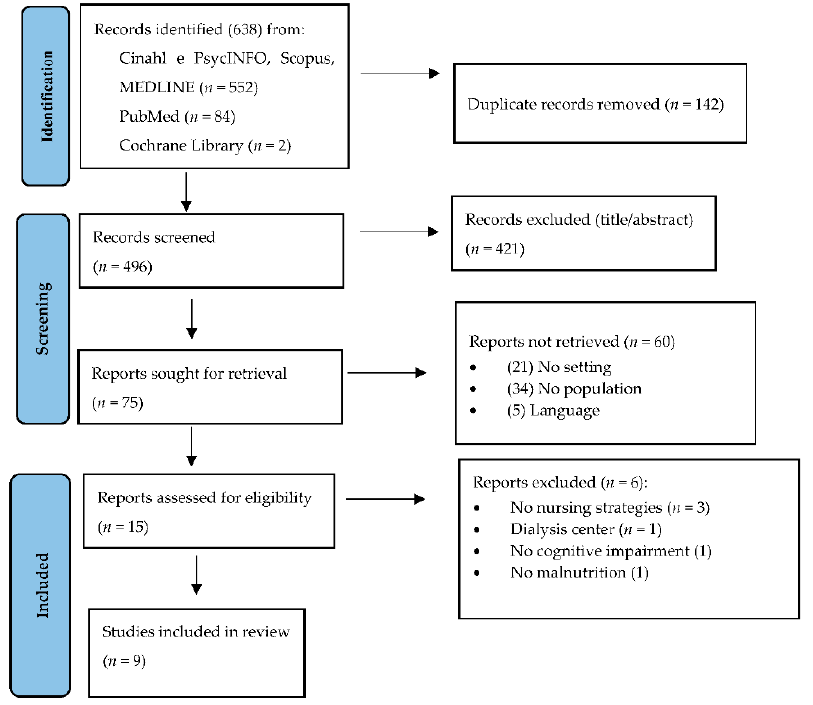
Figure 1. Flow diagram of the search and selection process, based on PRISMA flowchart.